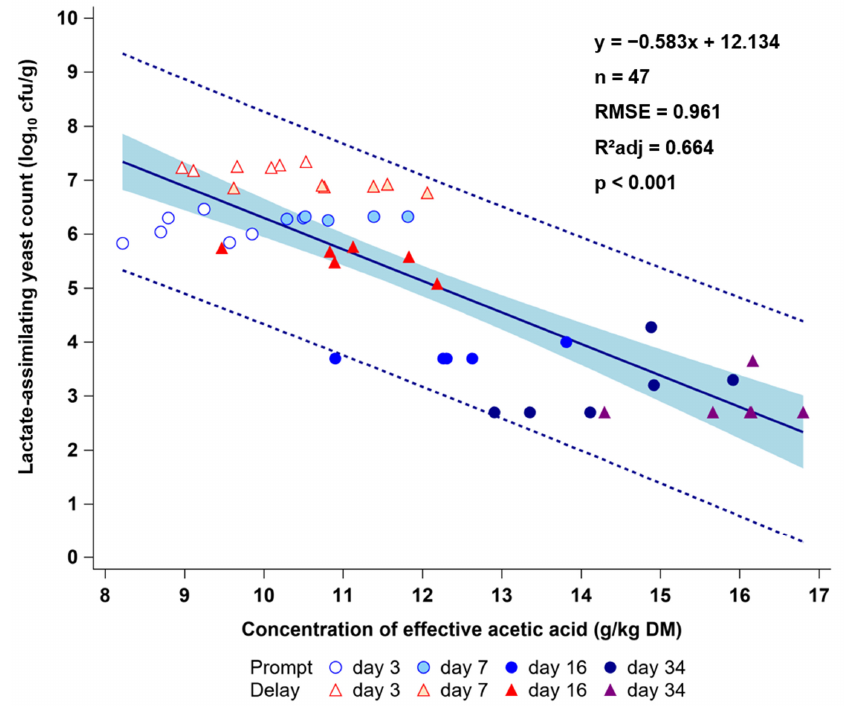
Figure 5. Relationship between the concentration of effective (undissociated) acetic acid and the count lactate- assimilating yeast count in maize silage during 34 days of storage. Auerbach et al. [40] demonstrated negative relationships between yeast count and ASTA (y = 819.4 x − 1.912, R 2 = 0.98, p < 0.001) with increasing acetic acid levels up to a maximum of 30 g/kg DM (y = 10.65 e 0.1702x , R 2 = 0.96, p < 0.001) in their experiments with grass and early cut rye silage [41]. The authors concluded from their experimental results